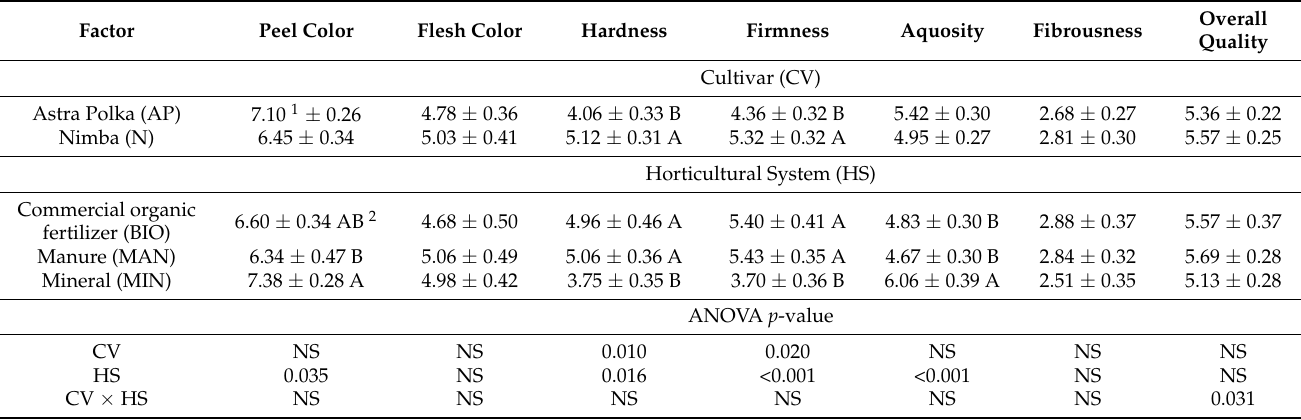
Table 8. The main effect of, and interaction between, cultivar and horticultural system on the appearance and physical attributes as well as overall quality assessment of courgette fruits.